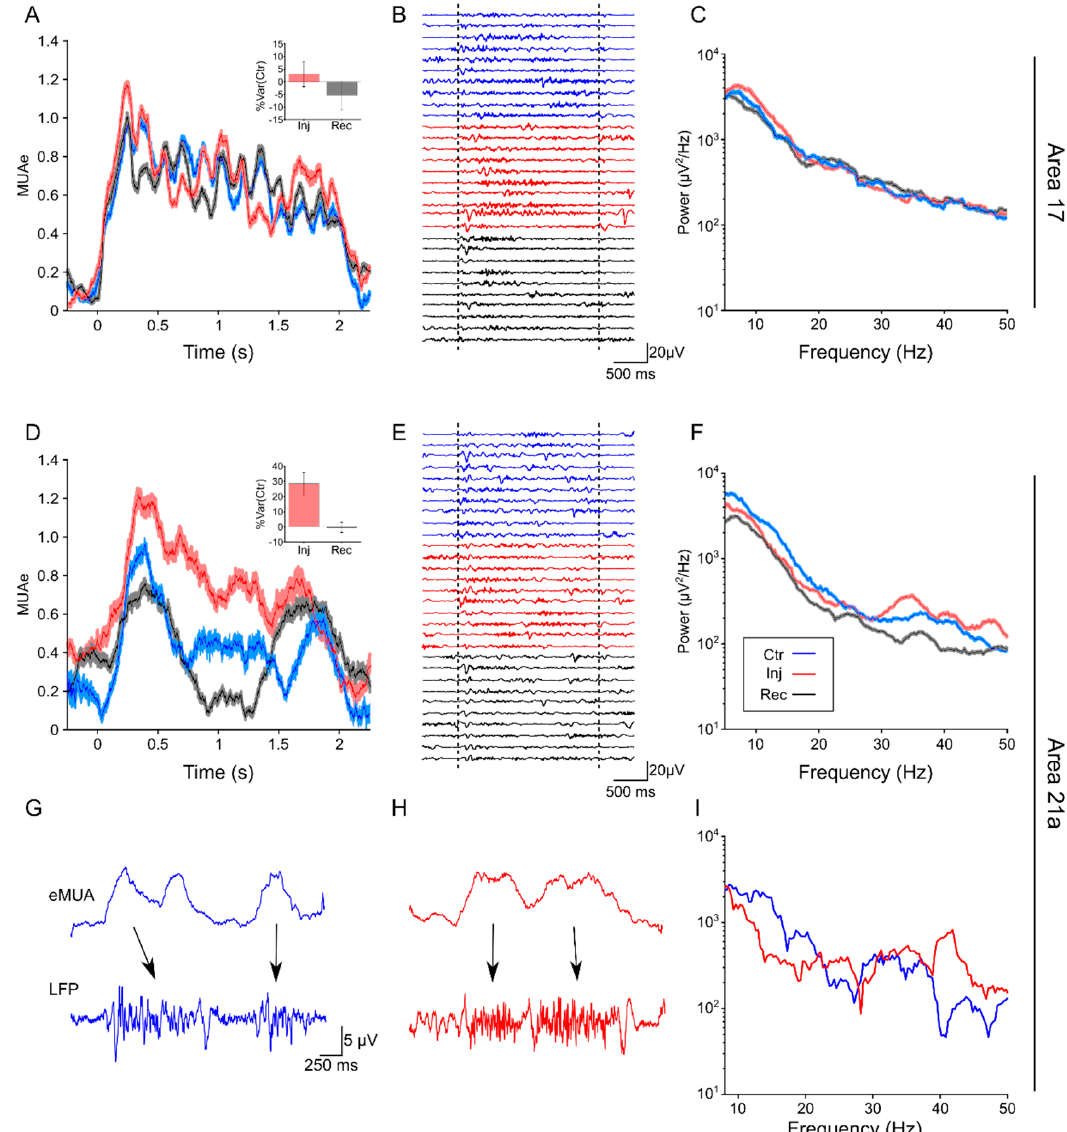
Figure 1. Oscillatory cortical responses during the inactivation of the LPl. Representative examples of simultaneous electrophysiological recordings in areas 17 and 21a, evoked by drifting gratings during control (Ctr, blue trace), injection (Inj, red trace) and recovery (Rec, black trace), conditions. ( A ) Average MUAe, ( B ) ten local field potentials (LFP) samples, and ( C ) average LFP power spectra are responses from an electrode placed in layer II / III of area 17 (Animal 2). The inset in A shows the %Var(Ctr) for Inj and Rec periods. ( D ) Average MUAe, ( E ) ten LFP samples, and ( F ) average LFP power spectra are responses from another electrode placed in layer IV of area 21a (Animal 2). The inset in A shows the %Var(Ctr) for Inj and Rec periods. ( G ) and ( H ) are cortical oscillatory responses that come from the same electrode shown in panels D, E, and F (layer IV, area 21a). Panels ( G ) and ( H ) show MUAe and LFP before and during the injection of GABA in the pulvinar, respectively. The arrows indicate the co-activation between the MUAe and the oscillatory activity in the LFPs. ( I ) LFP power spectrum evoked by the visual stimulation in Ctr and Inj conditions. Note that oscillatory response around the gamma band (40 Hz) is facilitated by the inactivation of the LPl (red line, panels ( H ) and ( I ). In panels ( A ), ( C ), ( D ) and ( F ), shadow areas represented the bootstrapping of random averages (1000 repetitions), to obtain a confidence interval at a threshold P =